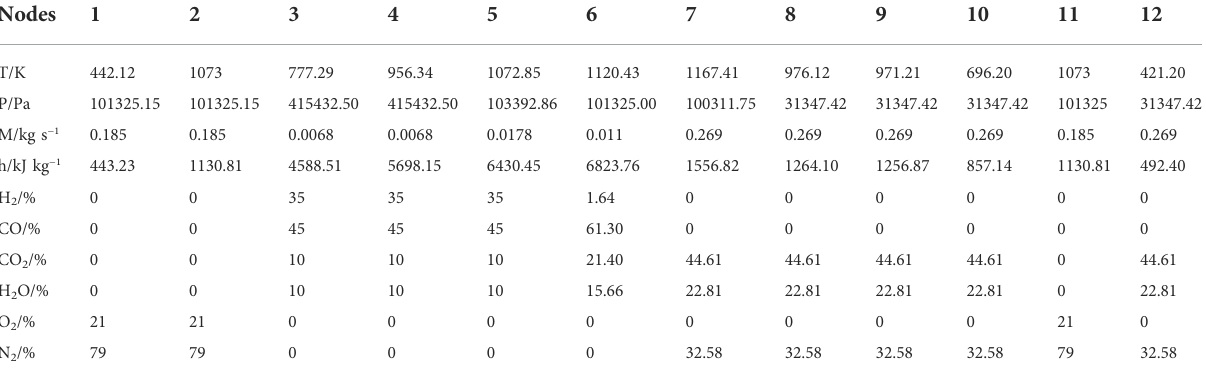
TABLE 2 IGFC each node